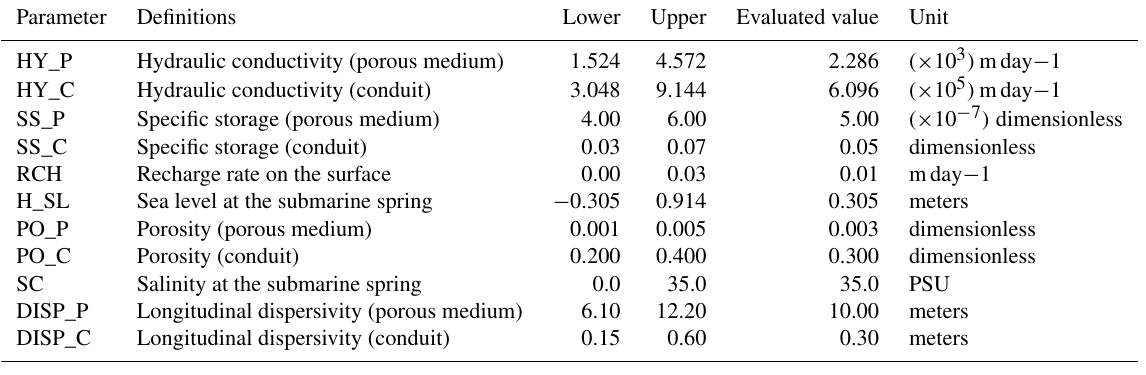
Table 1. The symbols and definitions of parameters used in this study, the specified evaluated values in local sensitivity study, and evaluation ranges (the lower and upper constraints) of each parameter in global sensitivity analysis.